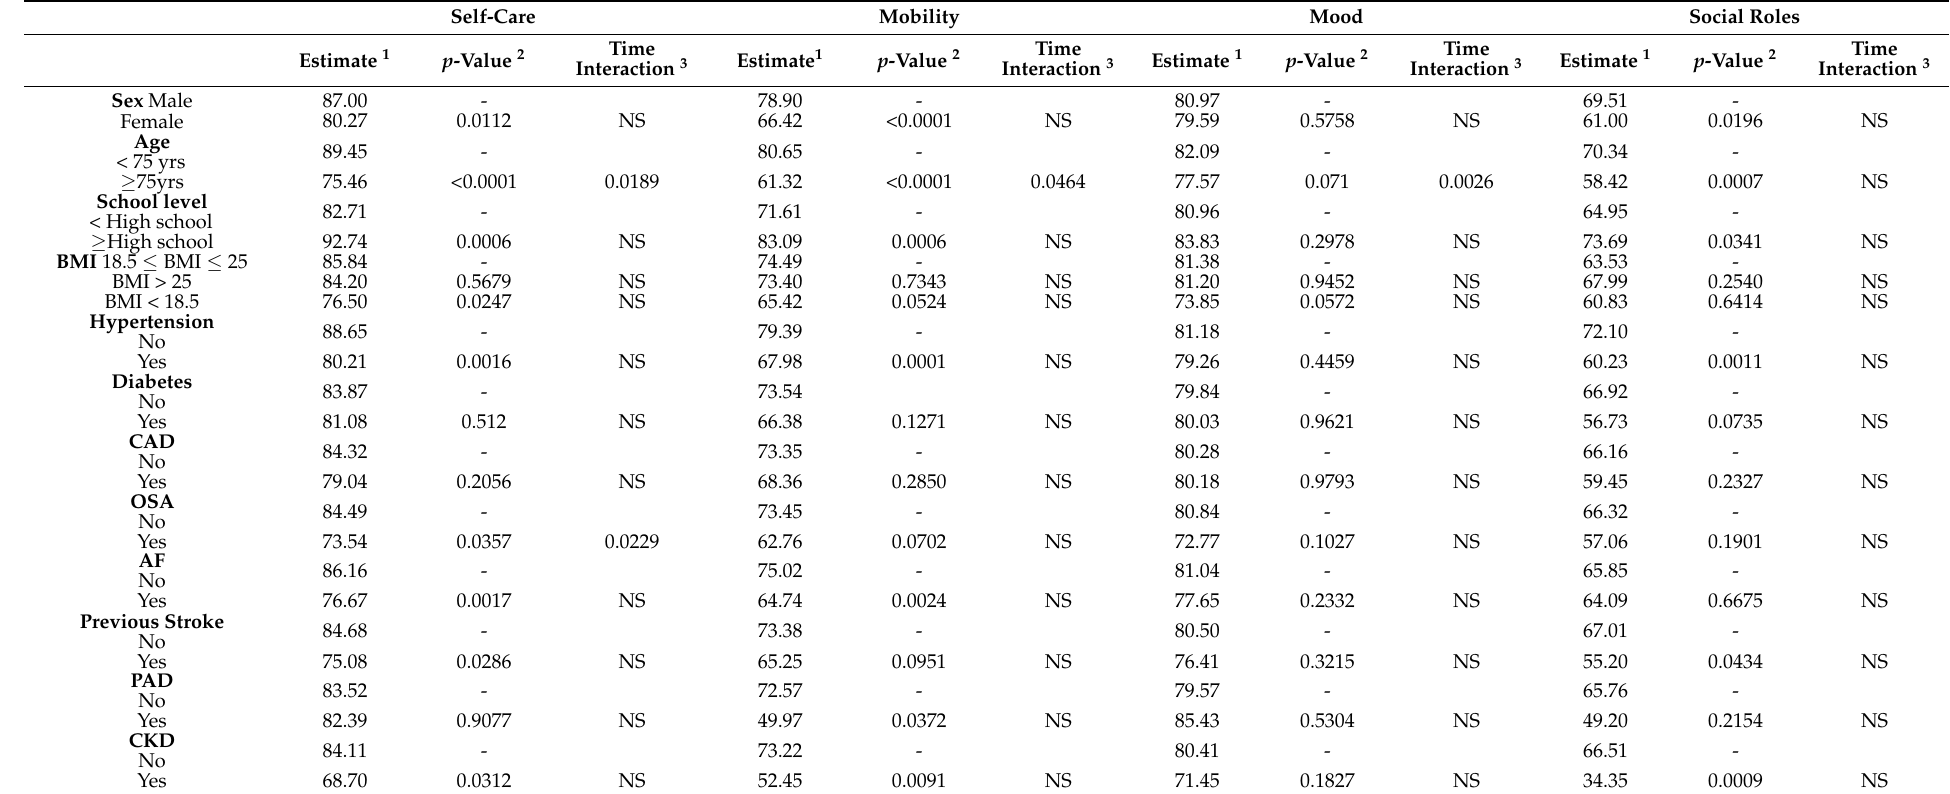
Table 3. Bivariate association between initial patient characteristics and SS-QoL outcome adjusted on time. Self-Care